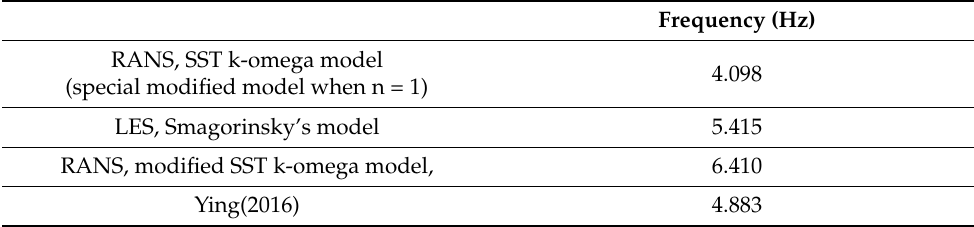
Figure 12. Velocity vector of the flow fields. ( a ) Re-entrant jet. ( b ) Vortex structure. To sum up, three turbulence models, the SST k-omega model, Smagorinsky’s turbu- lence model, and the modified SST k-omega model, were used. The results of shedding frequencies of these three turbulence models in all cases obtained from the data of the calculation output and the observation of the cavitation shedding are shown in Table 5, and these were compared with the data of other authors. The results show that the modi- fied SST k-omega model can predict the shedding frequency well when the n value is 10. The frequency value predicted by Smagorinsky’s model is also slightly larger, while the performance of SST k-omega model is not good. Table 5. Quantities predicted by the different turbulence models.